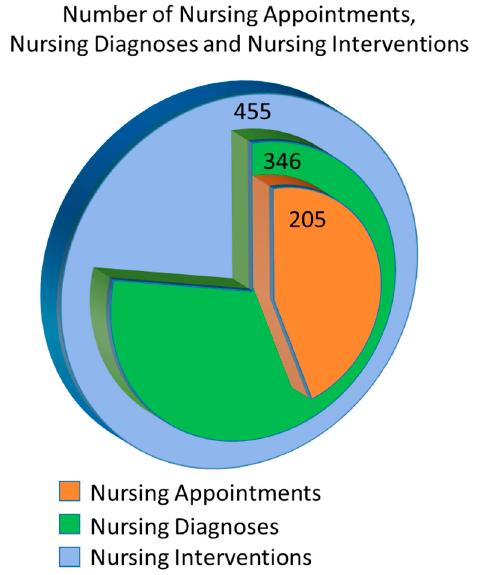
Figure 1. Comparison between the number of nursing appointments, nursing diagnoses, and nursing interventions, registered during the consultation.